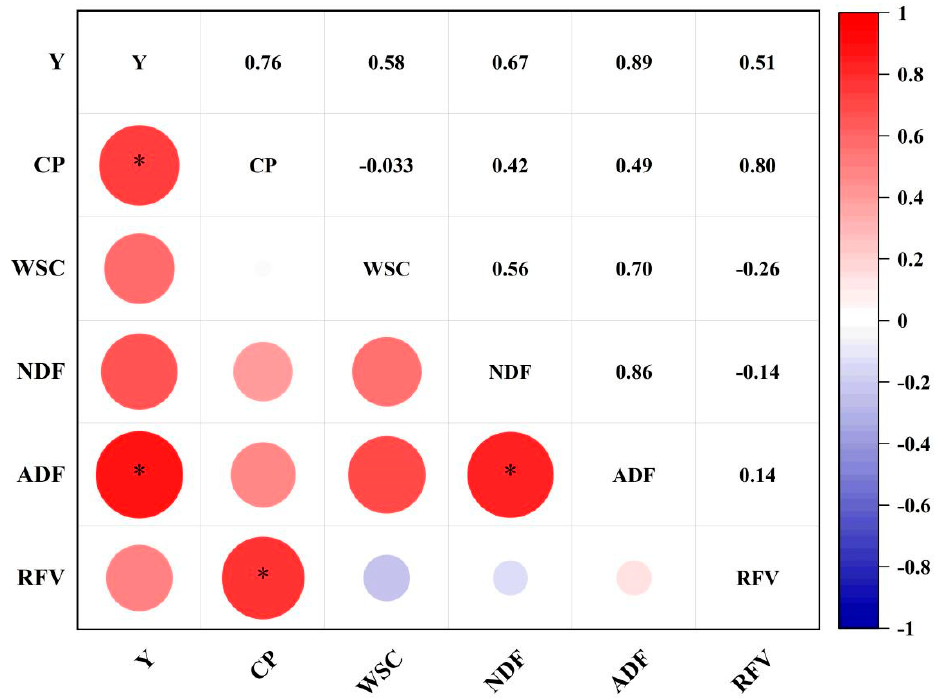
Figure 2. Relationship between biomass yield and nutritional quality parameters. Red color shows the positive correlation, and blue color shows the negative correlation (* p < 0.05). The intensity of color represents the significance of a variable. Y, biomass yield; DM, dry matter; WSC, water-soluble carbohydrates; CP, crude protein; NDF, neutral detergent fiber; ADF, acid detergent fiber; RFV, relative feed value.